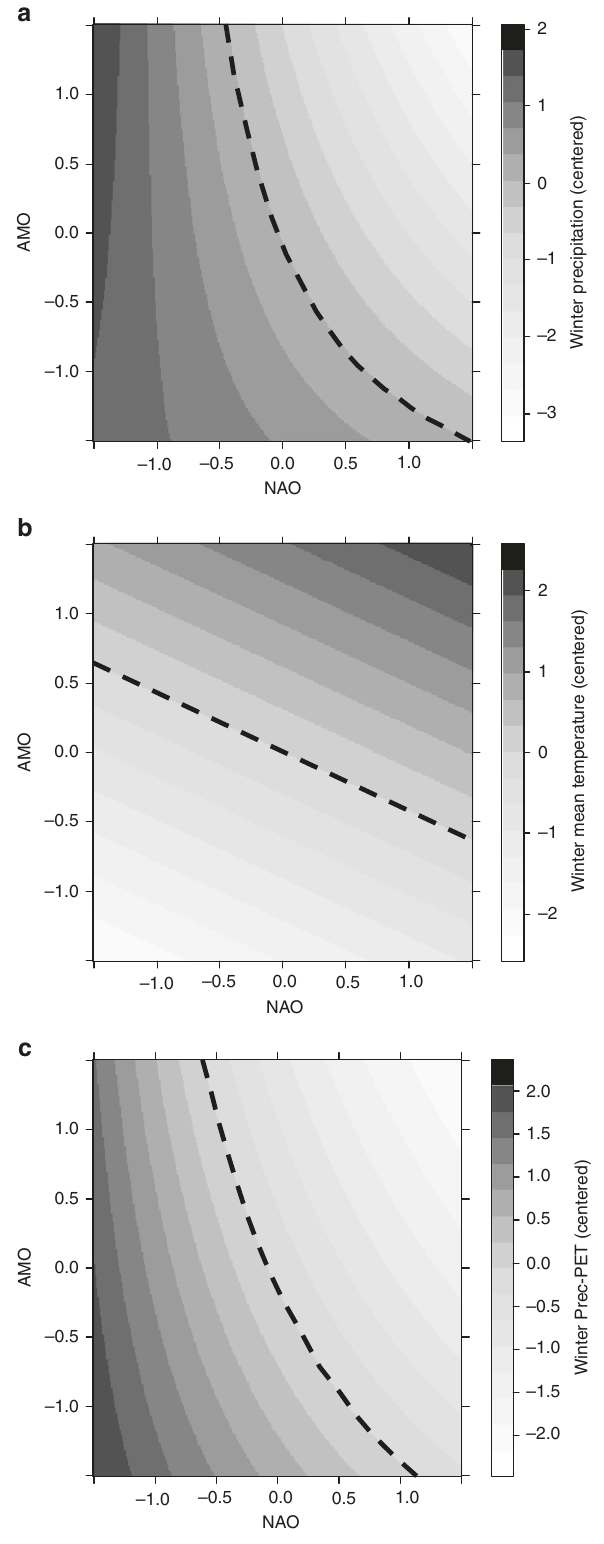
Fig. 3 North Atlantic Oscillations as drivers of local climatic variability. Predicted ( a ) winter total precipitation, ( b ) winter mean temperature, and ( c ) winter precipitation (Prec)-potential evapotranspiration (PET) as function of the North Atlantic and the Atlantic Multidecadal oscillations (NAO and AMO, respectively) using generalized linear models (gamma distribution of error and inverse link) in cases a and b , and a linear model in case c . Dependent variables were both centered ( y − y mean ) for an easier interpretation of colored isoline plots (dotted line represents y mean